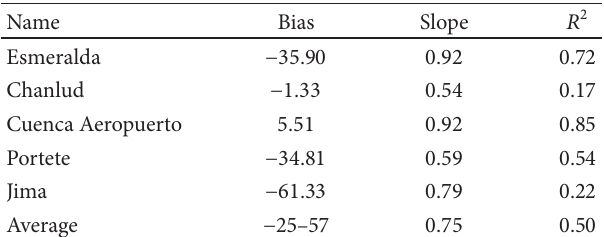
Table 3: Validation parameters for MLRM. Multiyear monthly mean precipitation observed versus modeled with MLRM. 𝑅 2 , bias, and slope.